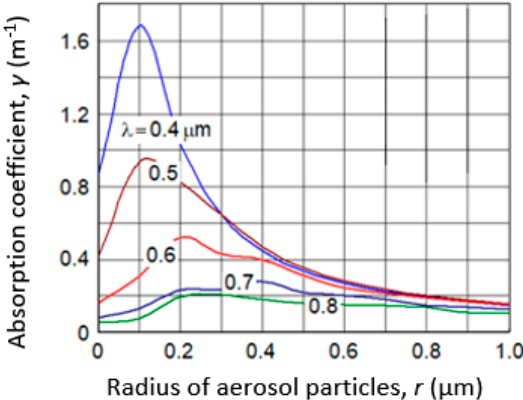
Figure 1. Absorption coefficient of solar radiation γ (m − 1 ) at dosage of aerosol composition 0.25 g/m 2 depending on aerosol radius r .